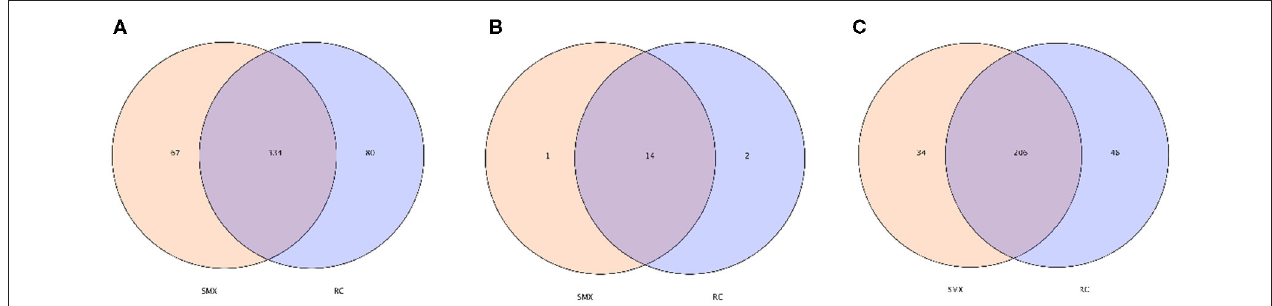
FIGURE 3 | Venn diagram. The Venn diagrams show the numbers of OTUs (97% sequence identity) (A) , phyla (B) and genera (C) that were shared or not shared by Sanmenxia(SMX) and Rongcheng(RC) individuals depending of overlaps (Sanmenxia Swan National Wetland Park in Henan: SMX; Swan Lake National Nature Reserve in Shandong Rongcheng: RC).